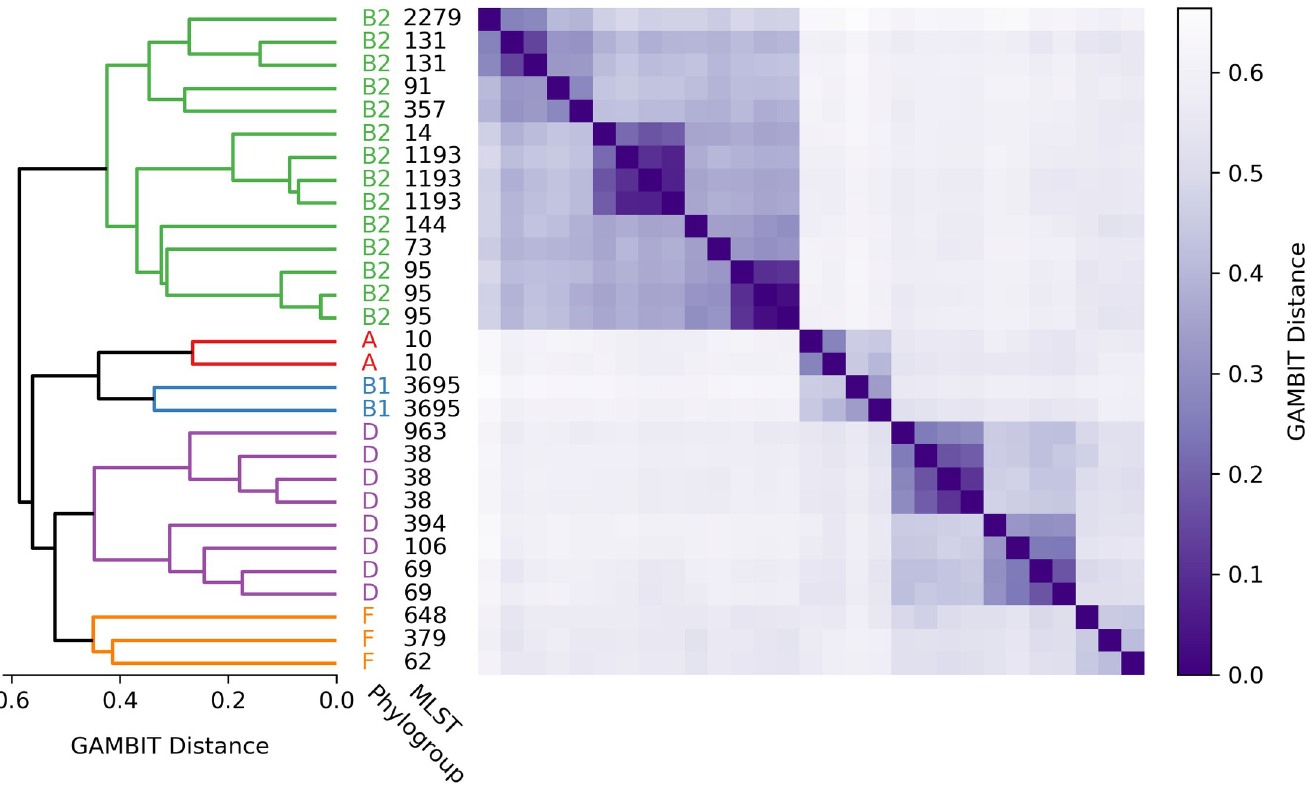
Fig 6. Phylogenetic tree estimated using GAMBIT distances. PCR and sequencing were used to perform multilocus sequence typing and determine the phylogroups of 29 E . coli genomes provided by the Stephens lab [27] (data set 5). We then calculated all pairwise GAMBIT distances (displayed as a heatmap on the right of the figure) for these genomes using standard parameter values, and used the resulting distance matrix to perform hierarchical clustering using the UPGMA method. The resulting tree groups both phylogroups (colored) and MLST types into clades.